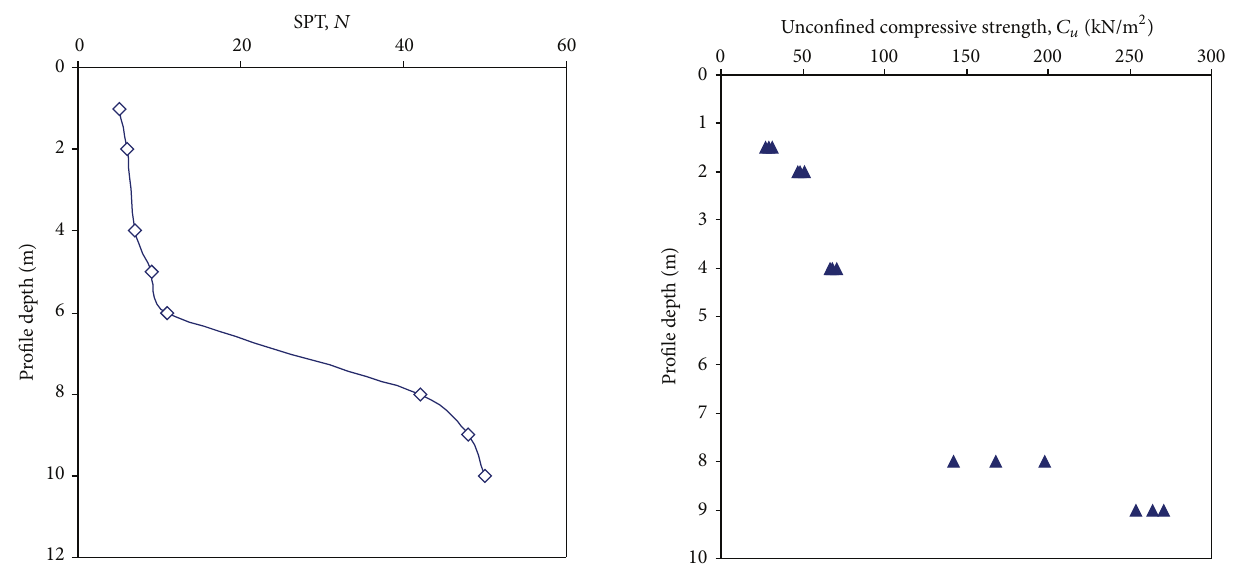
Figure 1: Typical SPT ( 𝑁 ) values obtained from borehole drillings.